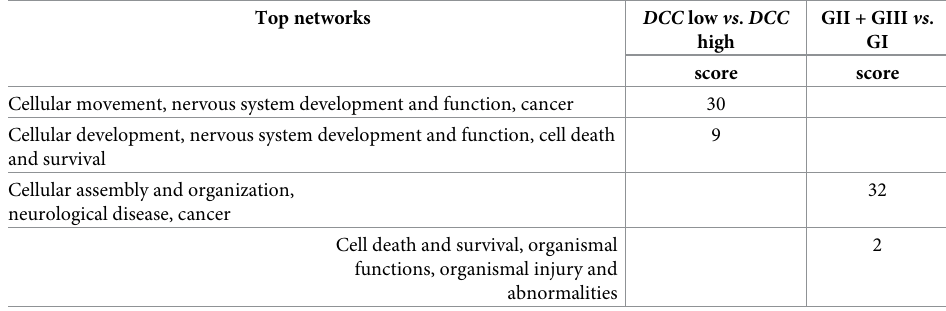
GII + GIII vs . high GI